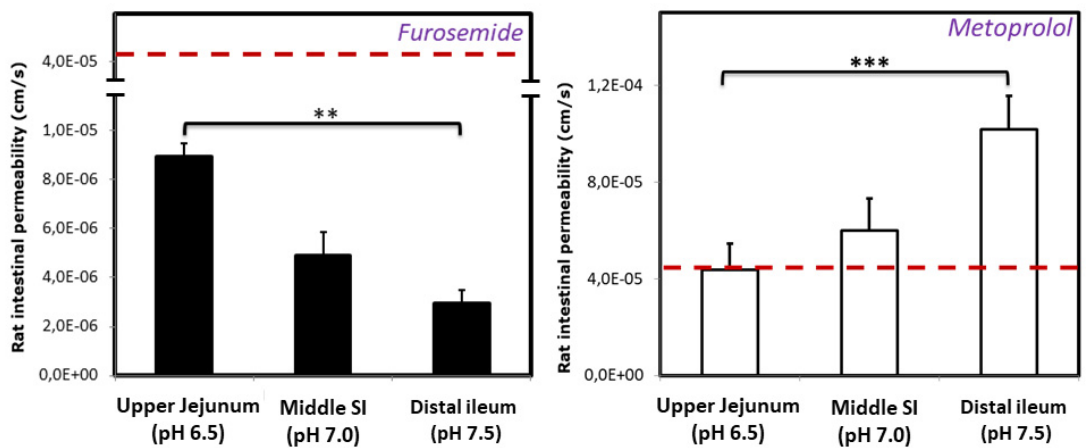
Figure 3. Effective permeability values (P eff ; cm/s) obtained for furosemide and metoprolol after in- situ single pass perfusion to the rat proximal jejunum at pH 6.5, mid-small intestine at pH 7.0, and to the distal ileum at pH 7.5. Mean ± S.D.; n = 4 in each experimental group; ** p < 0.01, *** p < 0.001.